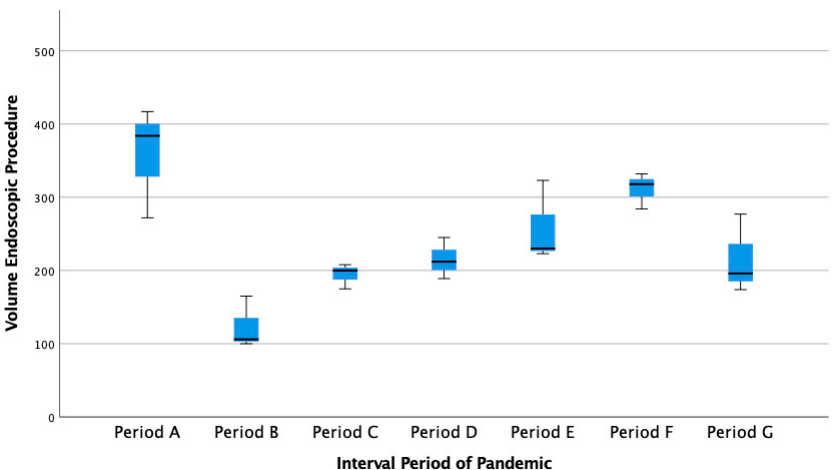
Figure 1. The pattern of Endoscopic Service Volume based on the COVID-19 Pandemic Interval Period.